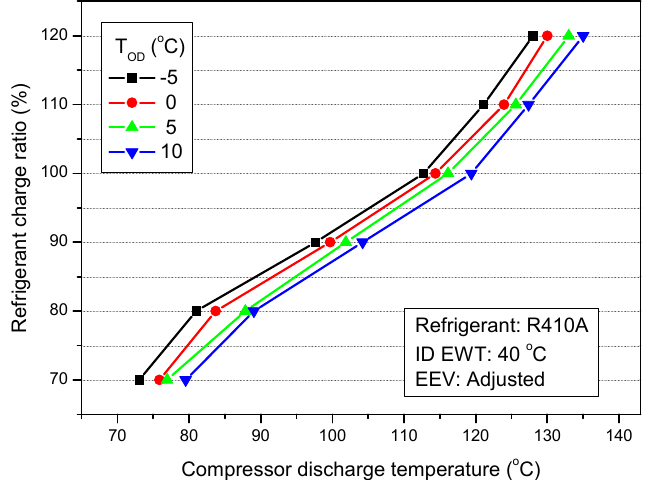
Figure 30. Compressor discharge temperature with variation of refrigerant charge ratio in heating mode.